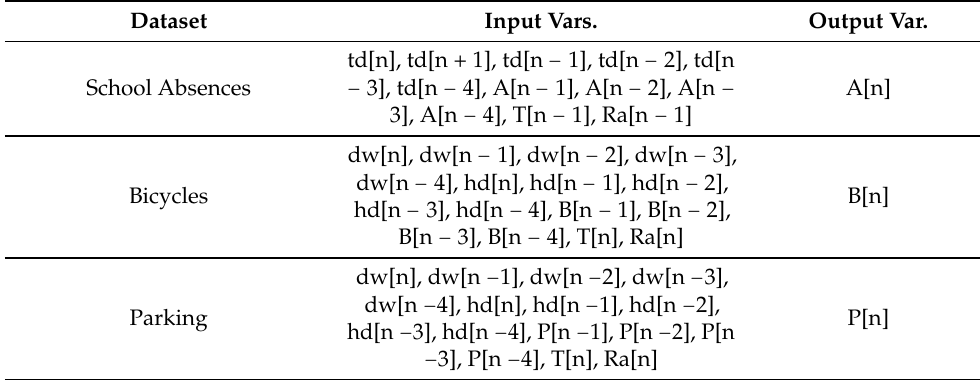
Table 5. Input and output variables for all datasets used for the evaluated ML regression methods. Acronyms of each variable are describe in Tables 1–4. Brackets indicate the time lag of each variable, that is x at the previous [⋅] day, etc. Input Vars. Output